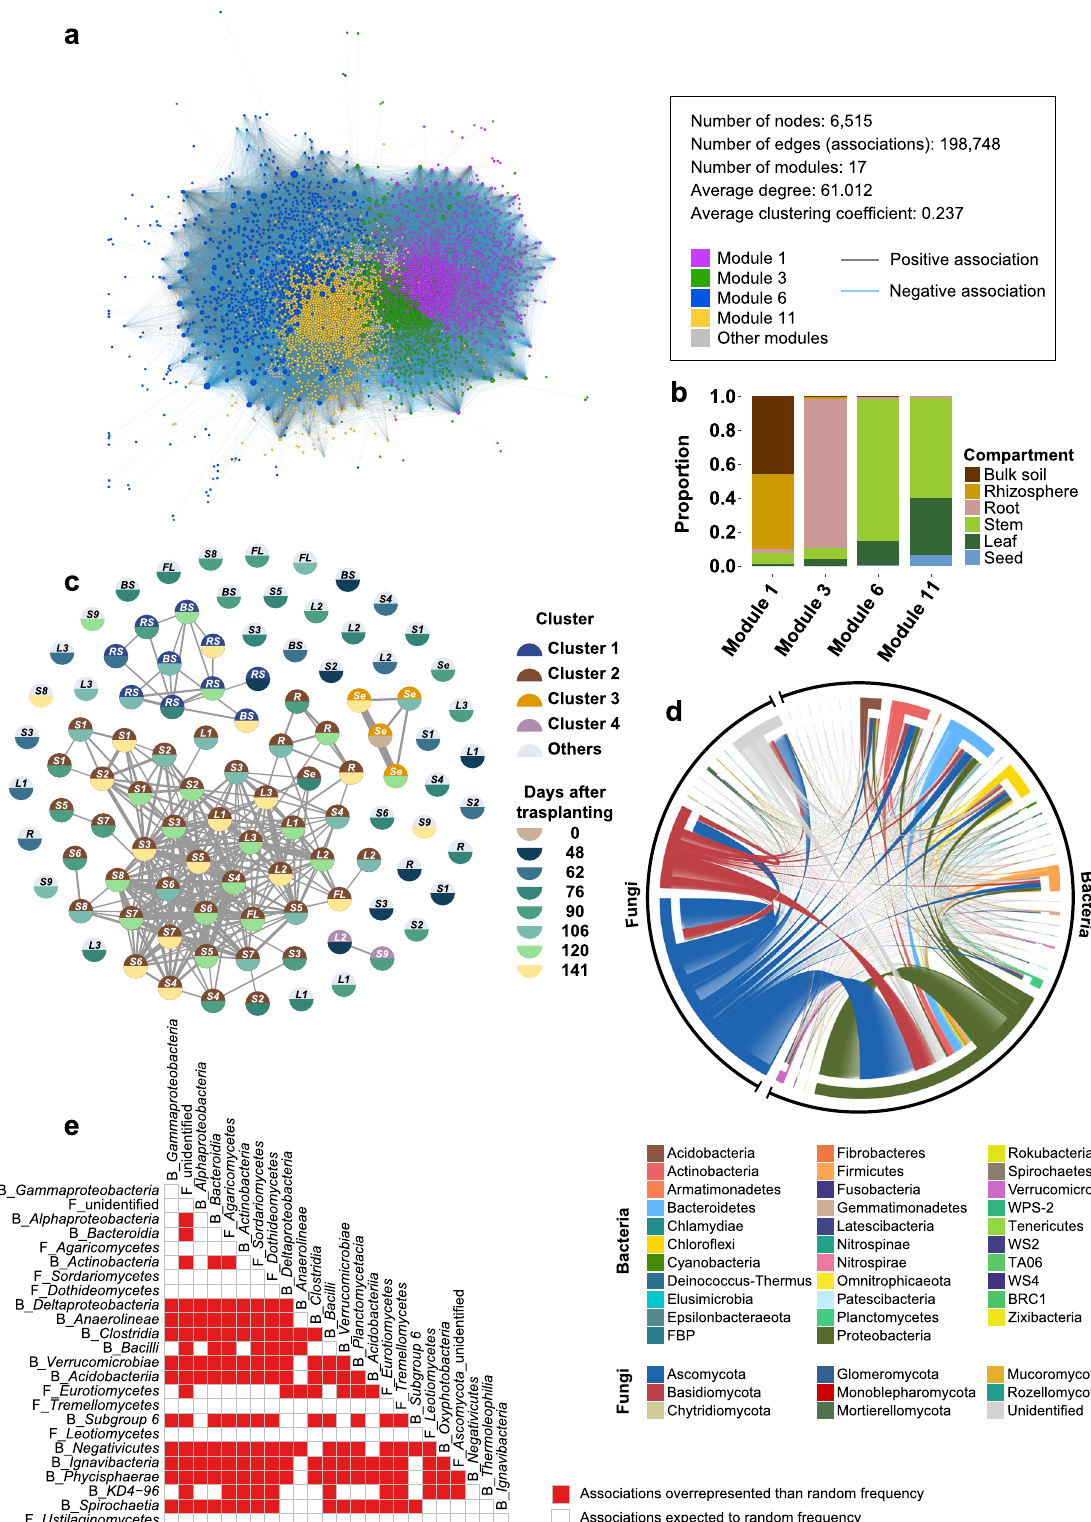
Sordariomycetes (order Hypocreales), Eurotiomycetes (order Eurotiales), Leotiomycetes (order Erysiphales), Agaricomycetes (order Polyporales), and Tremellomycetes (order Tremellales), bacterial-fungal associations showed non-random distribution but intra-kingdom associations did not. Microbial networks of each compartment showed the compartment-speci fi c